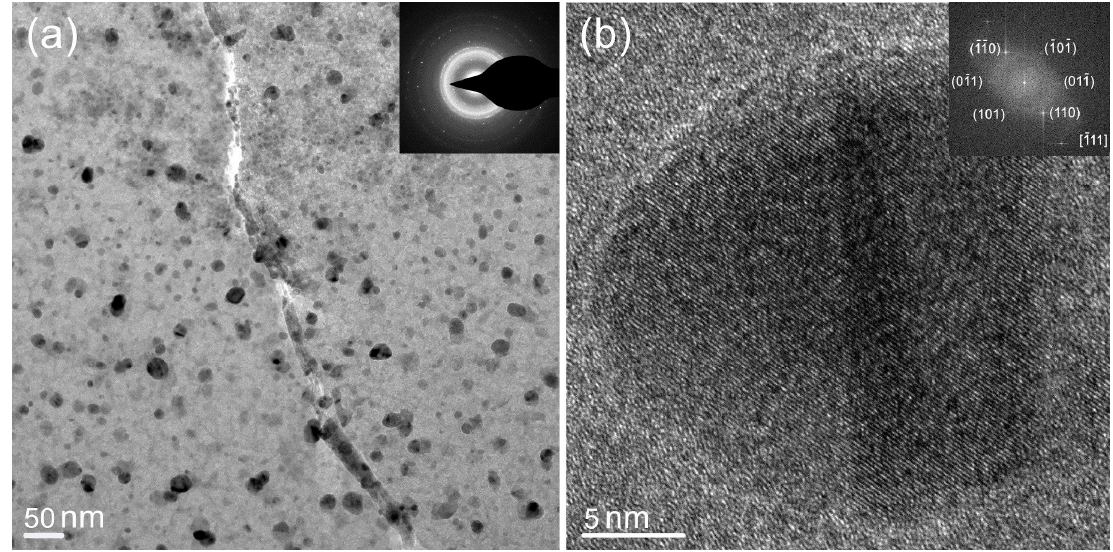
Figure 6. ( a ) Bright-field TEM image after the deformation and ( b ) the HRTEM image of the alloy after the application of the compressive test.